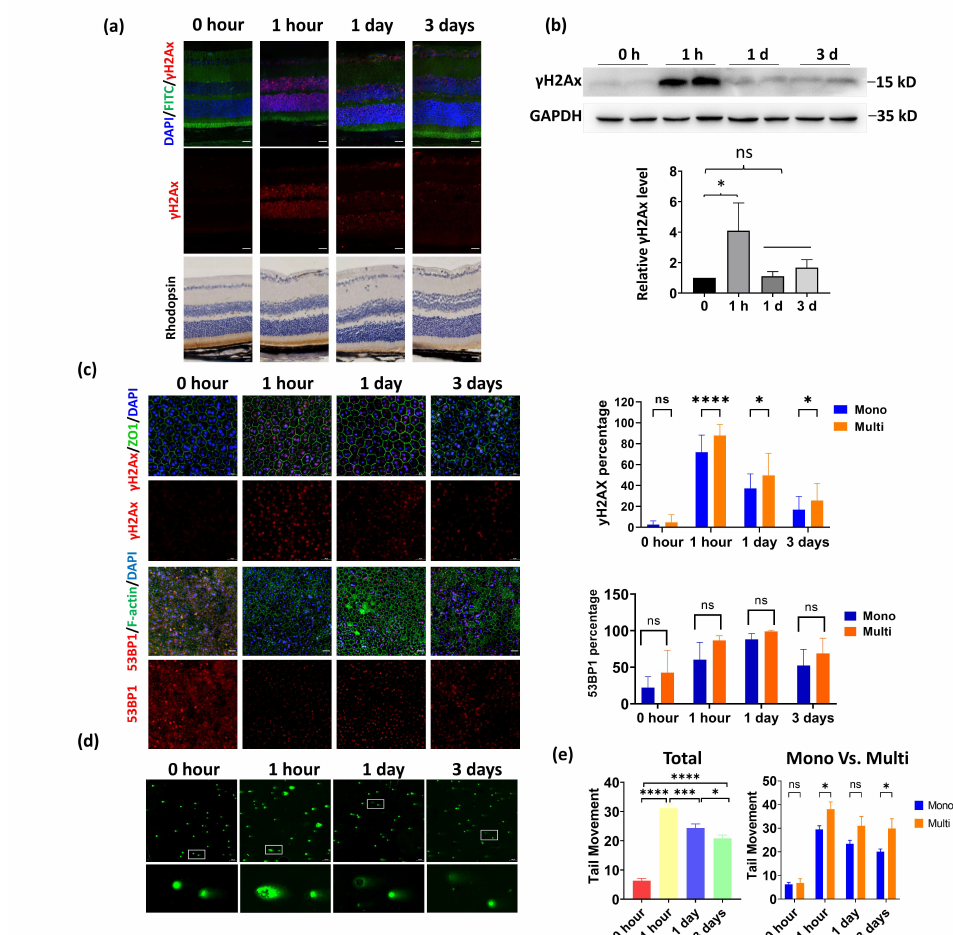
Figure 3. Multinucleated RPE cells exhibit reduced DNA repair efficiency compared to mononucle- ated RPE. DNA damage was induced by exposing the mice to 1 Gy of X-ray irradiation (IR). The retina and RPE were collected at 1 h, 1 day, and 3 days after IR. ( a ). IF and immunohistochemistry (IHC) analysis of retina cryosections. The DNA damage was indicated by γ -H2AX staining, and the cytoskeleton F-actin was labeled by FITC − phalloidin. The retina structure was further demonstrated by IHC staining of rhodopsin, the photoreceptor marker. Scale bar: 20 µ m. ( b ). WB analysis of the retina treated as described above. The quantification results of three independent experiments were shown in the bottom panel. *: p < 0.05. ns: not significant ( c ). IF images of γ H2AX and 53BP1 staining in the RPE at 1 h, 1 day, and 3 days after irradiation. Scale bar: 20 µ m. Right panels: quantitative analysis of the DNA damage comparing mononucleated and multinucleated RPE was completed by counting the γ H2AX-positive or 53BP1-positive cells. Forty regions in whole-mount RPE from 4 mice were randomly selected and quantified. * p < 0.05, **** p < 0.0001 and ns: not significant. ( d ). Comet assay showed DNA damage in RPE cells after IR. Neutral comet assay was performed using digested mouse RPE cells, which were collected at the indicated time point post-IR. The en- larged figure demonstrates a typical multinucleated and mononucleated cell. Scale bar: 100 µ m. ( e ). Quantitative analysis of tail movement at the indicated time post-IR. At each time point, more than 80 mononucleated and 15 multinucleated RPE cells were counted, respectively. * p < 0.05, *** p < 0.001, **** p < 0.0001, ns: not significant. All data are shown as mean ±